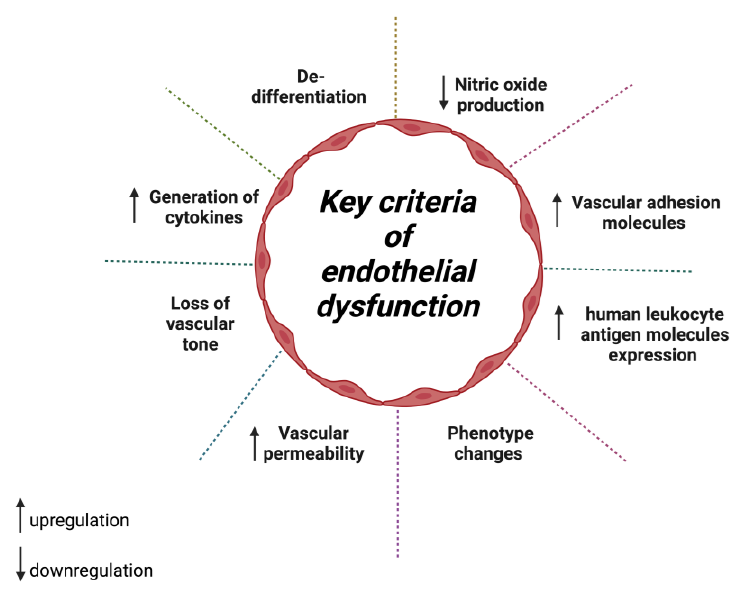
Figure 1. Critical criteria to define endothelial dysfunction.